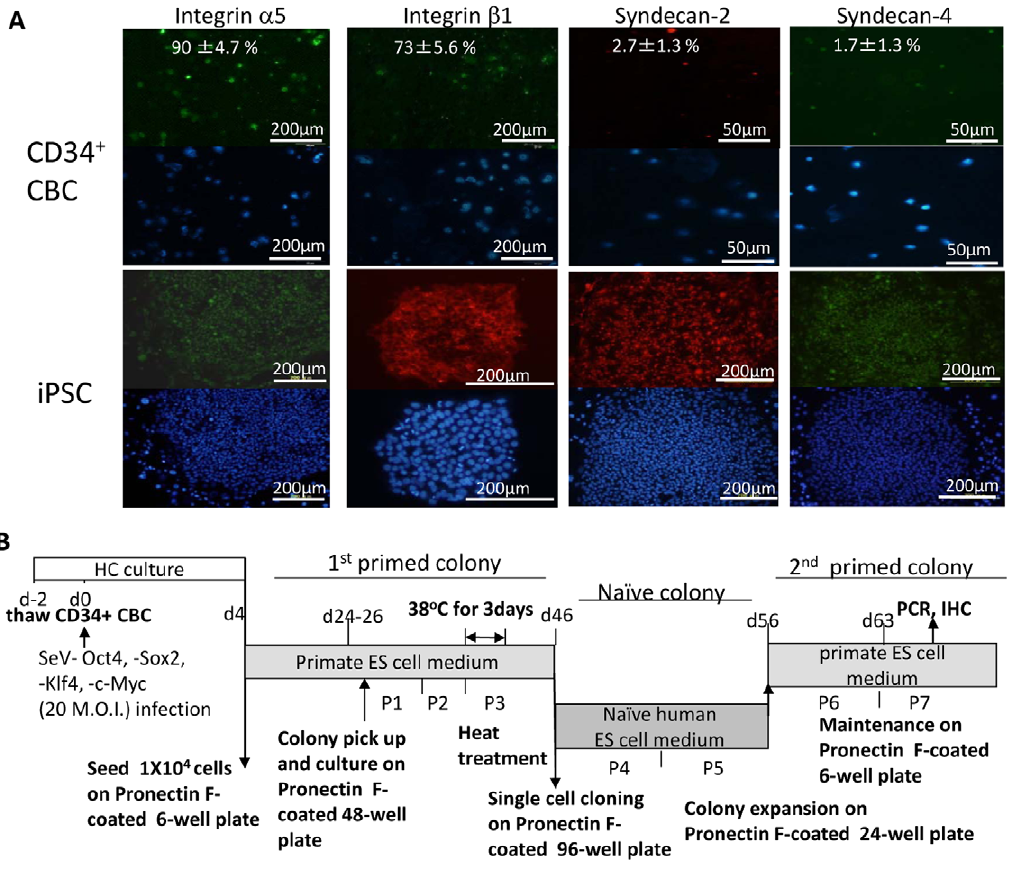
Figure 1. Expression of surface molecules on CD34 + cells and iPSCs. (A) Adhesion molecules integrin a 5, b 1, syndecan-2, and -4 on CD34 + CBCs (upper panels) and iPSC colonies (lower panels) detected by immunostaining with the relevant antibody. Alexa 594- and Alexa 488-conjugated secondary antibodies (red and green, respectively) were used to visualize the staining. Nuclei were stained with DAPI (lower photos). Means of the percentages of positive cells with standard deviation are appended in the right top of the photos. (B) Protocol for generation of iPSCs from CD34 + CBCs on Pronectin F-coated dishes with temperature sensitive SeV vectors. P: passage.